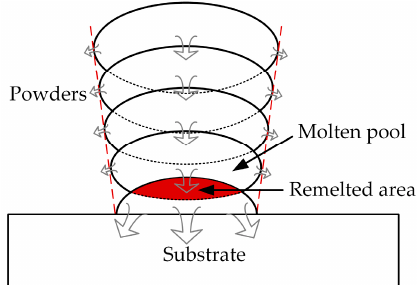
Figure 11. Mechanism of heat dissipation and overlap profiles of single tracks (support structures) in multiple layers.